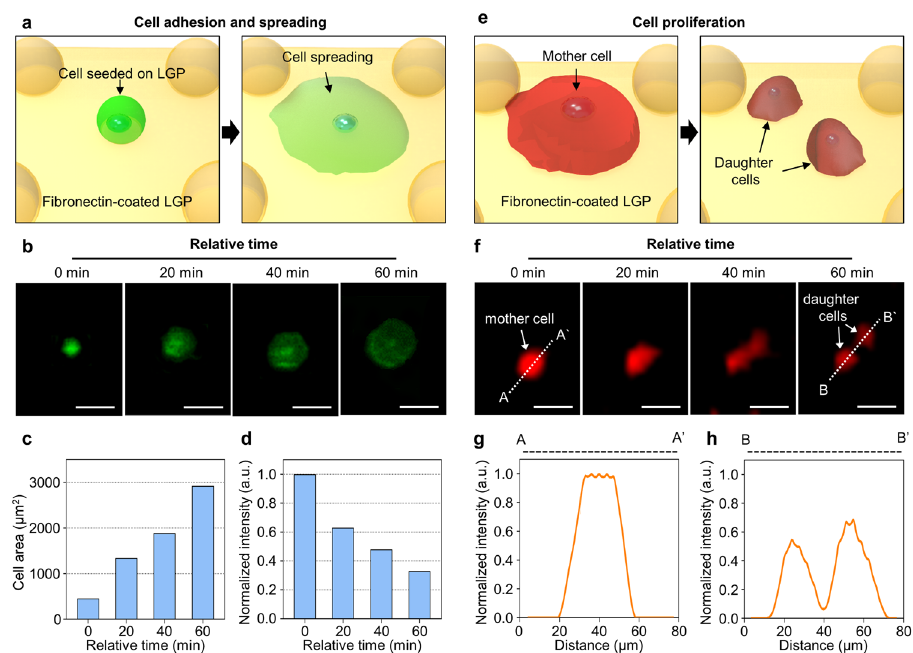
Fig. 7 Dynamic characteristics of green- and red-labeled NIH 3T3 fi broblast cell. a Schematic diagram of the spreading of a labeled cell on PDMS substrate coated with fi bronectin. b Dynamic images of a labeled cell during the spreading process. c Changes in cell area by cell spreading. d Changes in measured intensity by cell spreading. e Schematic diagram of labeled cell proliferation on PDMS substrate coated with fi bronectin. f Dynamic images of a labeled cell during the proliferation process. One mother cell was divided into two daughter cells. g Cross-section intensity of the mother cell before cell proliferation. h Cross-section intensity of the daughter cells after cell proliferation. Scale bar: 100 μ m ( b , f ).